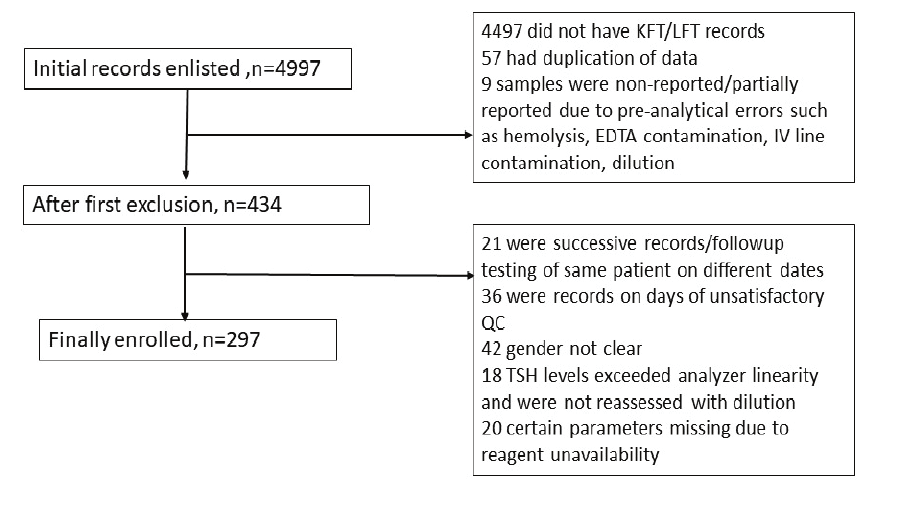
Figure 1 : Scheme of data enrollment.